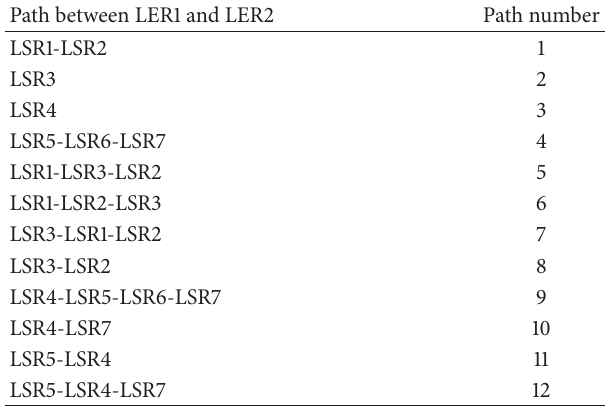
Table 1: Available paths.